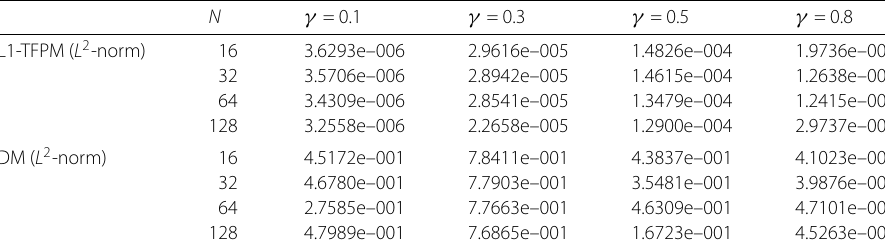
Table 2 Comparison of L 2 -norm error between the difference scheme and the method in the paper